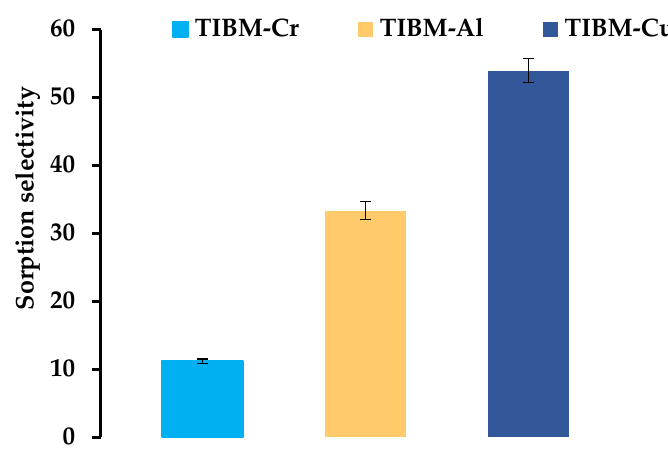
Figure 7. CO 2 /N 2 selectivity for TIBM-Al, TIBM-Cr, and TIBM-Cu. Error bars represent the standard deviation (n = 3). Table 3. CO 2 adsorption capacities of different